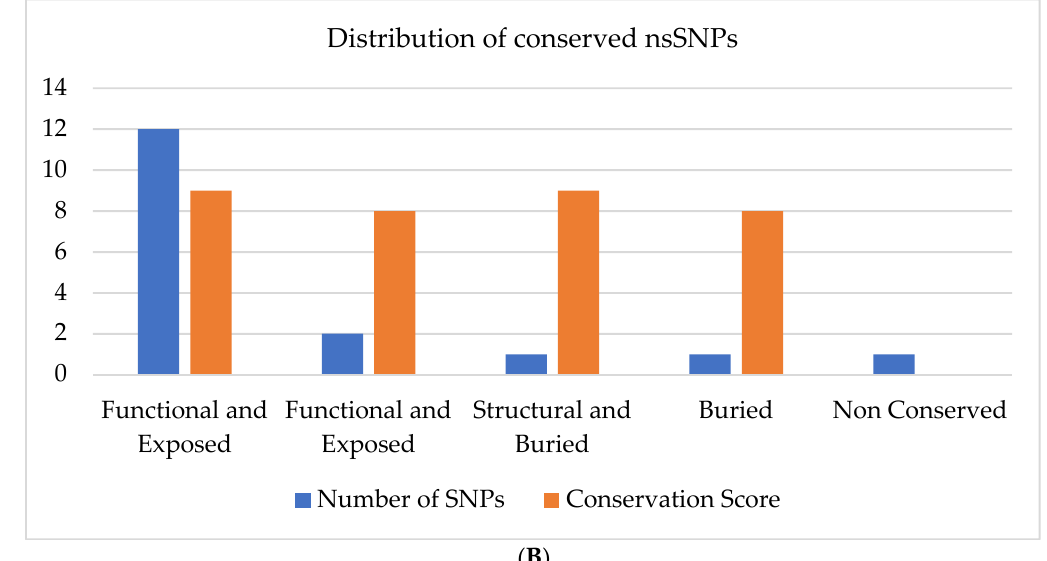
Figure 4. ( A ) Conservation analysis of nsSNPs using ConSurf. ( B ) Distribution of high-risk nsSNPs of TP63. C347F showed loss of di-sulfide bridge that affects the stability of the TP63 protein Table 3. Prediction of structural and functional consequences of nsSNPs in TP63 through structure. R343Q, R266Q, R319H, R337Q, and R318H were observed to cause (1) smaller Project HOPE. sizes of amino acid residue, (2) loss of positive charge, and (3) increased hydrophobicity Size & Charge in the protein. Glycine (G) is very flexible and possesses a particular conformation for the SNPs Characteristics & Features TP63 protein; D351G or G349E disrupts the protein structure. HOPE created images for Wild-Type Mutant the nine SNPs using a partial 3D structure of the TP63 protein (PDB ID: 3QYN). These R376C Large & (+ve) Small & (0) SNPs are present in the DNA binding domain showing the wild-type and mutated resi- dues at one position with two different colors (Figure 5). Therefore, we decided to perform molecular docking for these nine DNA binding domain SNPs.